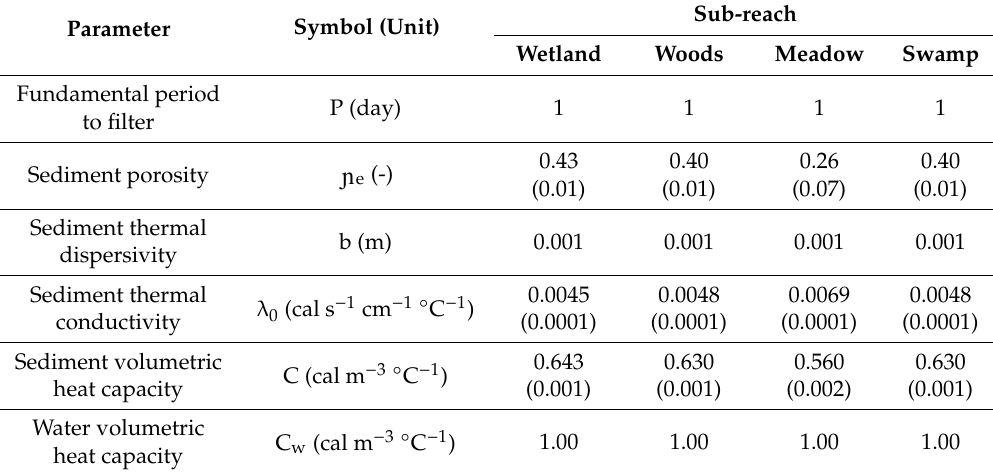
Table 1. Means (and standard deviations, if ≠ 0) of input parameters of VFLUX2 [57] used in this study for each sub-reach.